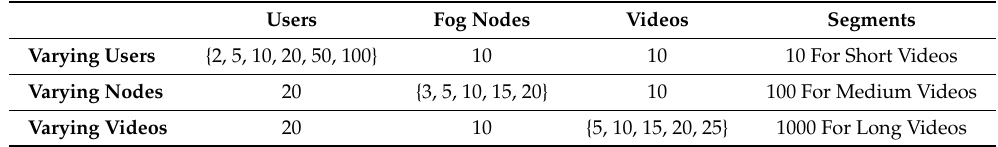
Table 1. Simulation